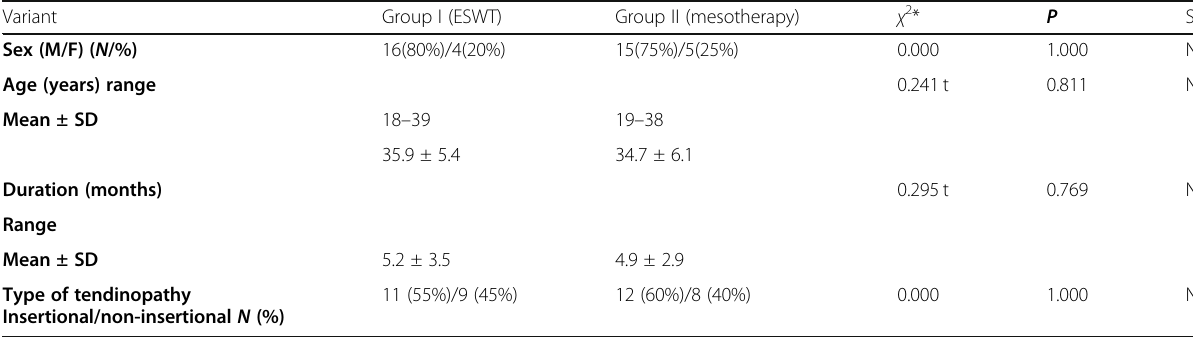
Table 1 Descriptive data of the two groups Variant